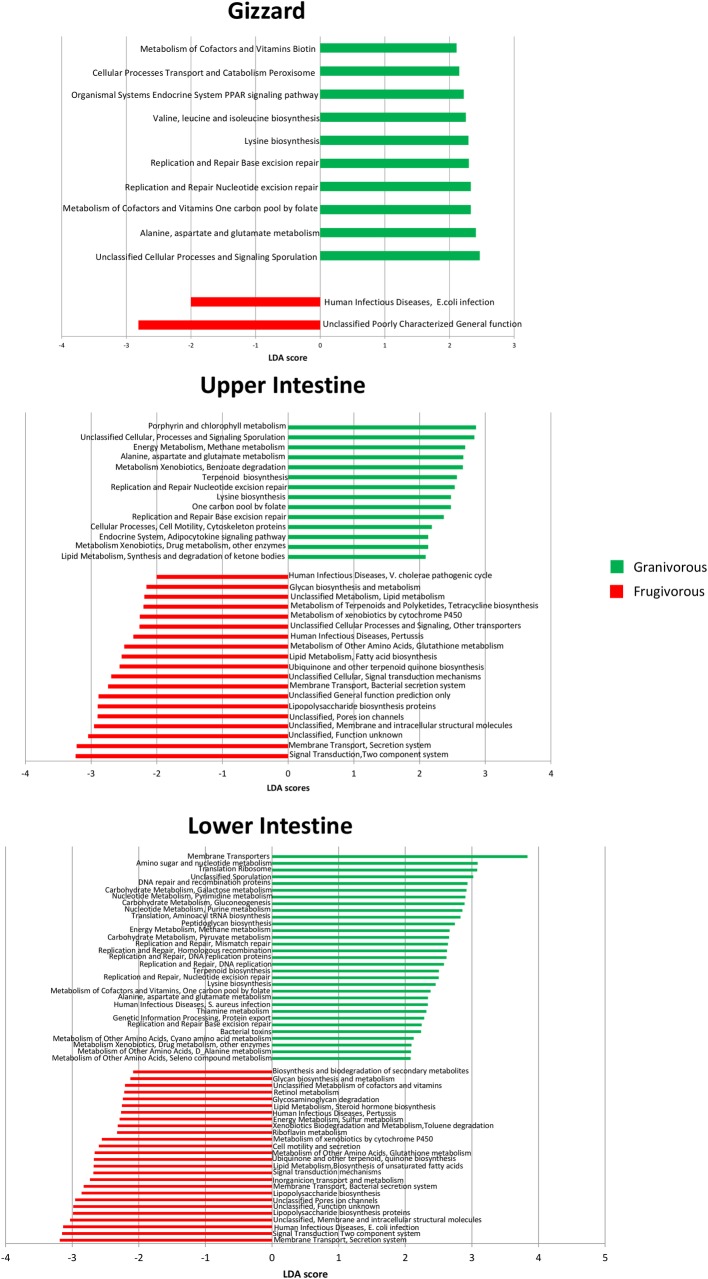
Linear discriminatory analyses (LEfSe) comparing KEGG module predictions using PICRUSt in different organs from granivorous and frugivorous birds (LDA>2).